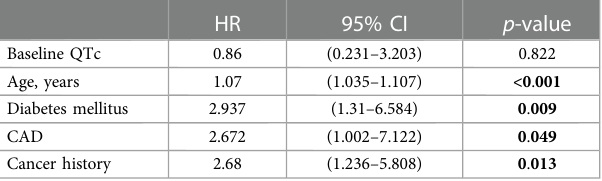
TABLE 5 QTc interval analysis at hospital admission and 7 months after COVID-19 survivors hospital discharge. QT